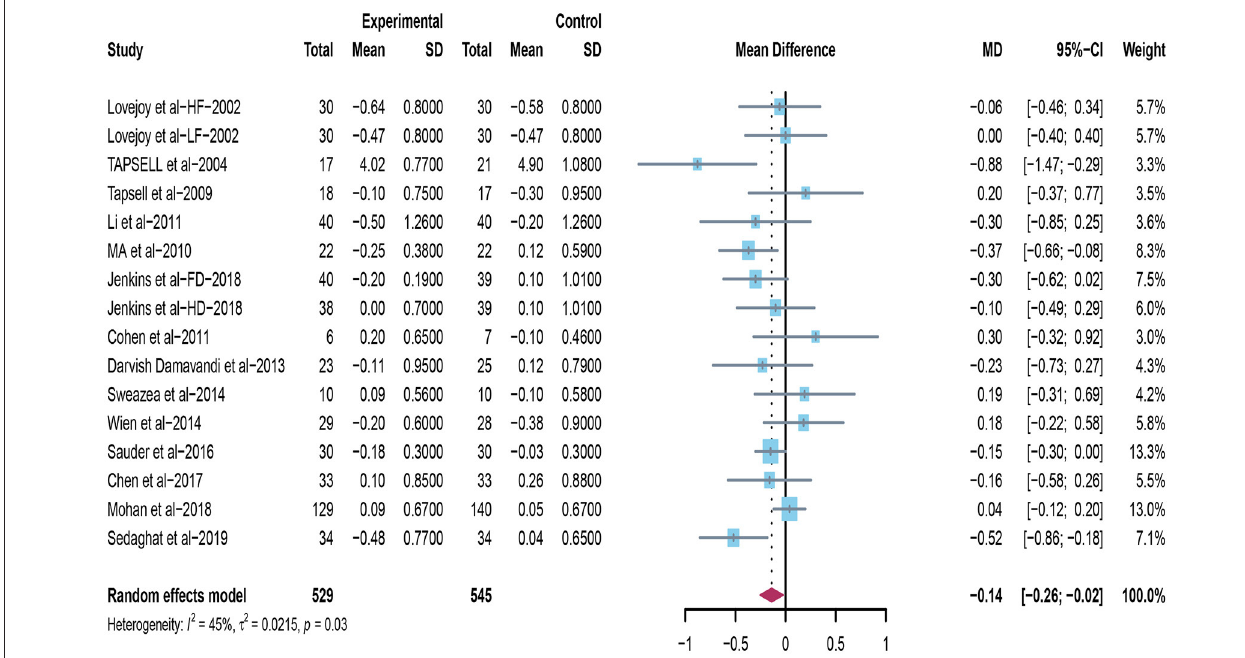
FIGURE 5 | Effect of peanuts and tree nuts supplementation on total cholesterol (mmol/l) in patients with type 2 diabetes.